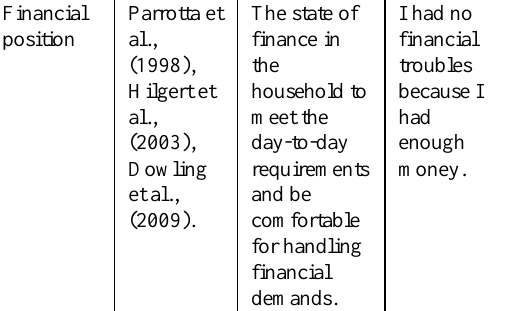
Table 2: Demographic Distribution of